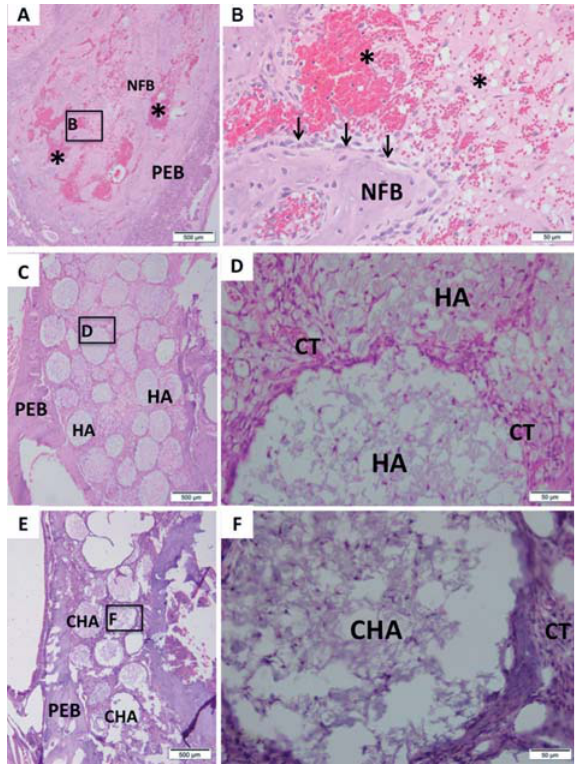
Figure 6- Representative photomicrographs of alveolar